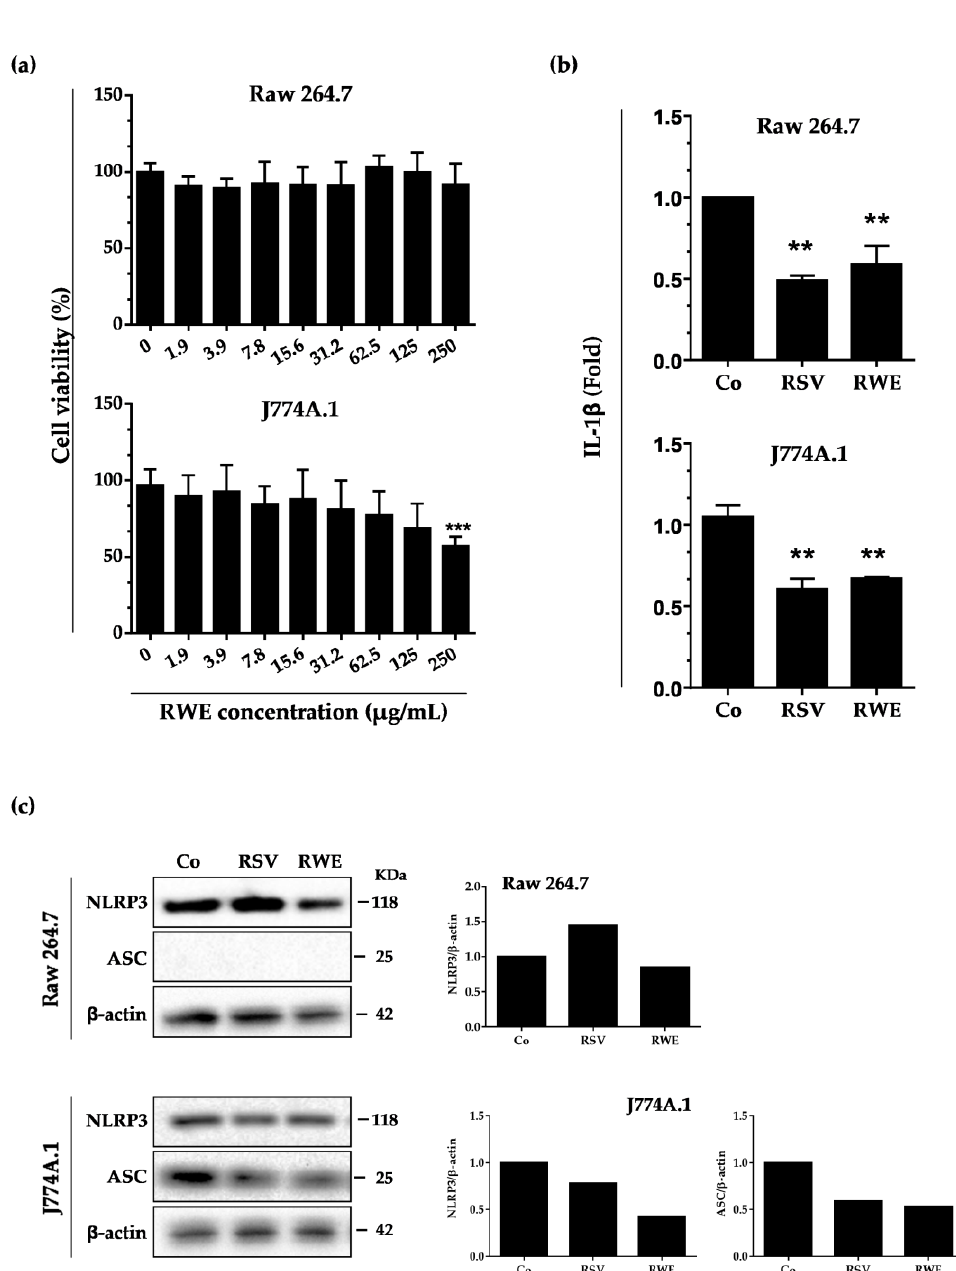
Figure 1. RWE and Resveratrol (RSV) decrease IL-1 β secretion in resting conditions through the modulation of the protein expression levels of NLRP3 inflammasome components. ( a ) Cell viability of Raw 264.7 and J774A.1 was determined by crystal violet staining after 24 h of treatment, with concentration ranges of RWE (starting concentration 250 µ g/mL, 1:2 serial dilutions). Data are expressed as mean percentages ± s.d. of three independent experiments. p -values were determined by a one-way ANOVA with Holm-Sidak correction. *** p < 0.001. ( b ) Secreted IL-1 β in supernatants was analyzed by ELISA after 6 h of treatment with vehicle (DMSO, Co), RWE (100 µ g/mL), or RSV (60 µ M). Data are expressed as fold changes in secreted IL-1 β levels as compared to vehicle-treated cells (Co) and are mean ± s.d. of three independent experiments. p -values were determined by the multiple Student t test. ** p < 0.01 ( c ) Western blot analysis of NLRP3 and ASC protein expression in Raw 264.7 and J774A.1 macrophages after 6.5 h of treatment with vehicle (DMSO, Co), RWE (100 µ g/mL) or RSV (positive control). Left panels: representative blots from three independent experiments are shown. β -actin was used as loading control. Right panels: densitometry quantifications of representative blots. Plotted data are fold changes as compared to vehicle-treated cells